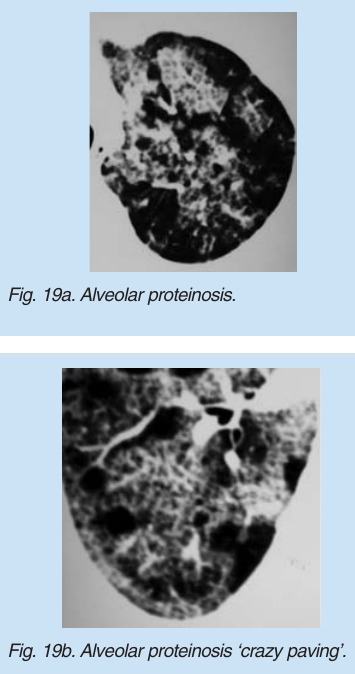
Fig. 19b. Alveolar proteinosis ‘crazy paving’.